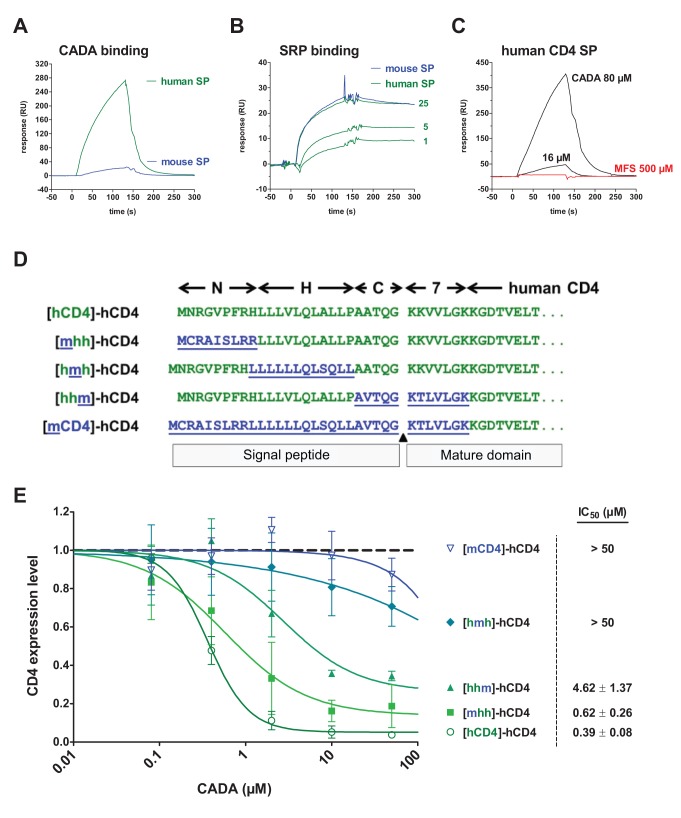
CADA binds to the signal peptide of human CD4 and interacts primarily with its hydrophobic H-region.(A) Binding of CADA to the SP of human but not to mouse CD4. Chemically synthesized peptides composed of the signal sequence and eight N-terminal residues of mature CD4, plus a PEG11 linker and a biotinylated lysine at the C-terminus, were captured on a streptavidin C1 chip for SPR analysis. The chip density was 84 and 153 resonance units (RUs) for human and mouse SP, respectively. Graph shows interaction of CADA (160 µM) to hCD4 SP (green) but not to mCD4 (blue). (B) As in (A), but for the binding of SRP to the SPs. The chip density was between 120 and 130 resonance units (RUs). Graph shows dose response of SRP (nM) to hCD4 SP (green). Similar binding of SRP (25 nM) was observed for mouse CD4 SP (blue). (C) The inactive CADA-analog MFS105 (MFS, red line) did not bind to the hCD4 SP (up to 1,000 µM), whereas for CADA a dose-dependent binding was measured (black lines). The chip density was 95 RUs. For clarity of the figure, only the 500 µM line is shown. Comparable data were obtained in an independent experiment shown in Figure S4D. (D) Schematic representation of the constructs used. The N-, H-, and C-regions of the SP of hCD4 were exchanged for those of mouse CD4. Also the first seven N-terminal residues of the mature protein were swapped as indicated. The residues of hCD4 are depicted in green, whereas those of mouse CD4 are in blue and underlined. (E) Flow cytometry analysis of HEK293T cells transiently transfected with the expression plasmids from (D) and left either untreated or treated with CADA for 48 h. Cells were collected and stained for hCD4. CD4 expression levels were normalized to non-treated controls (n≥3). The IC50 values of CADA for each construct are included.